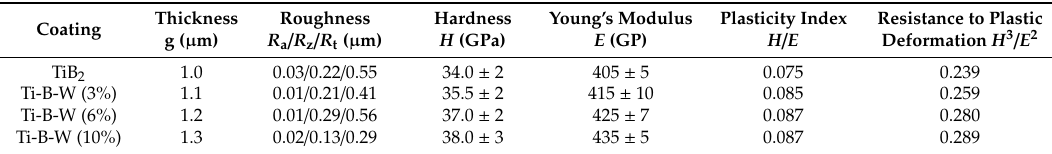
Table 2. Parameters for investigated TiB 2 and Ti-B-W coatings.